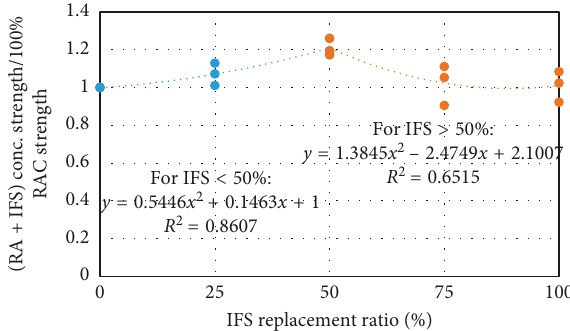
Figure 15: Compressive strength ratio between RA + IFS and 100% RAC with respect to IFS replacement ratio.